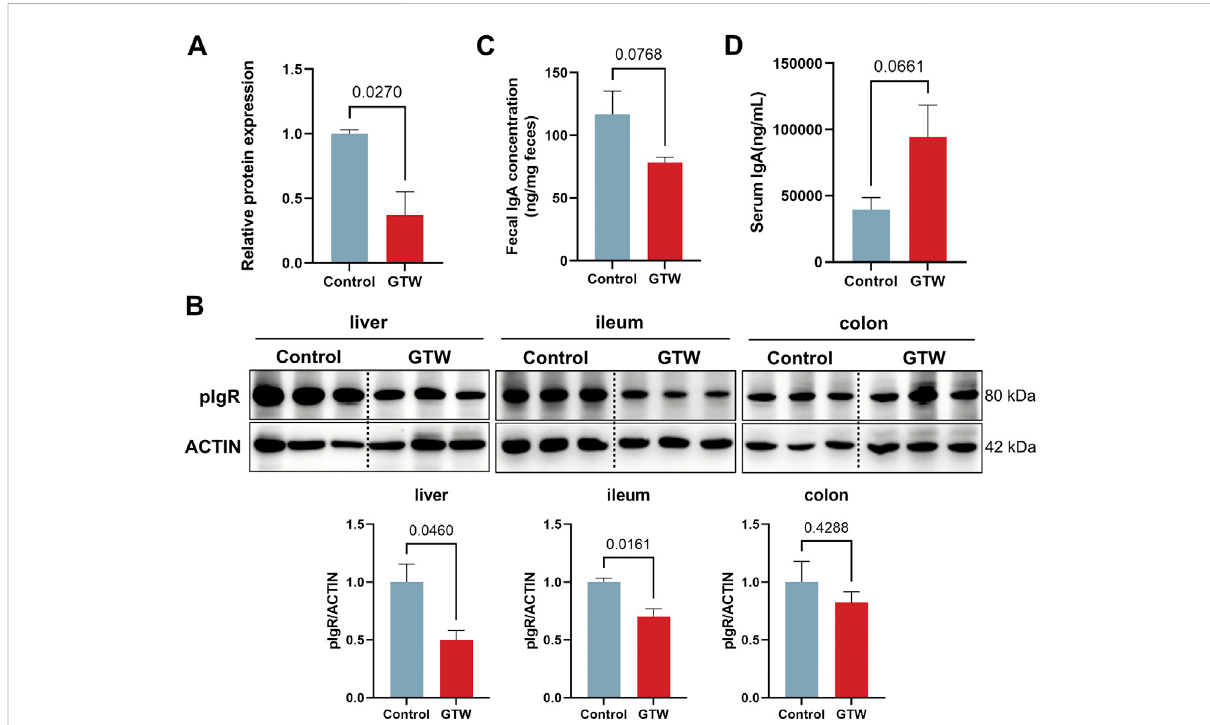
FIGURE 5 GTW affected the activation of intestinal immune network for IgA production pathway. (A) Relative pIgR protein expression according to proteomicsresults( n =3). (B) TheproteinlevelsofpIgRinliver,ileumandcolonweredeterminedbywesternblot( n =3). (C) IgAlevelsinfeces( n =5) and (D) serum ( n = 5) were measured after GTW treatment. The band density was calculated using ImageJ software. Data are presented as mean ± SEM. p < 0.05 was considered statistically signi fi